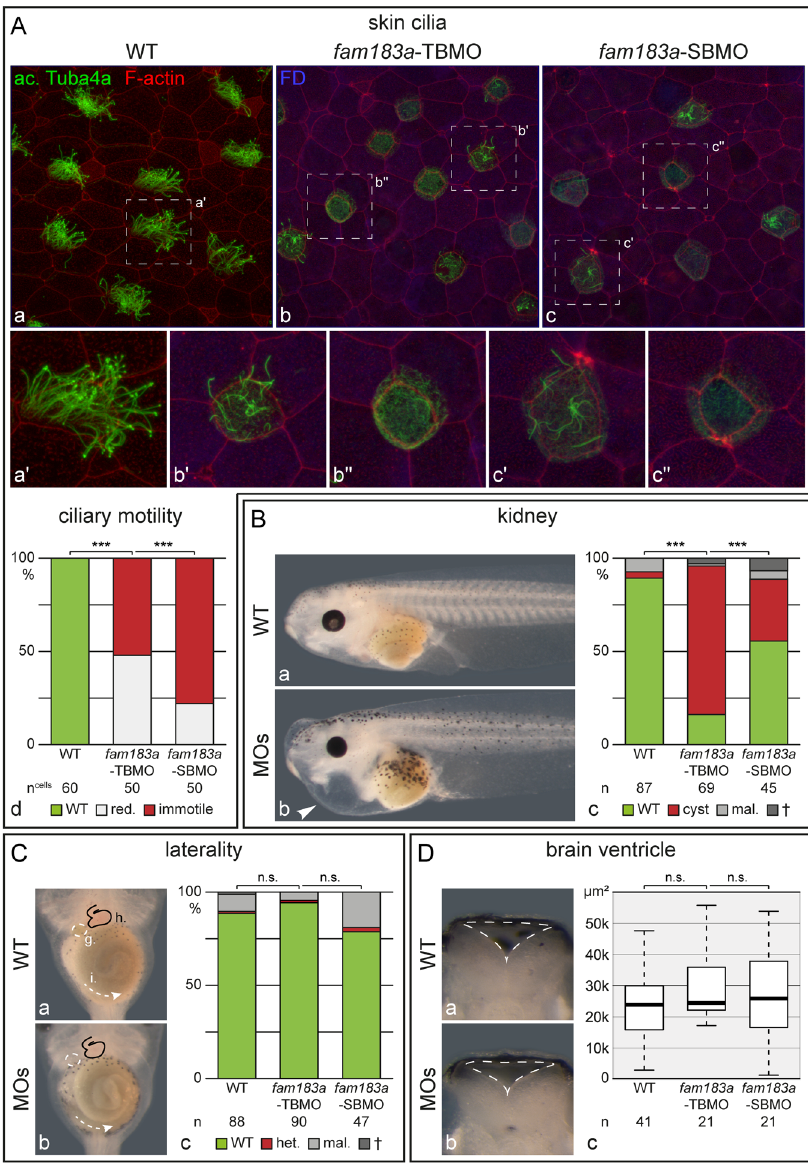
Figure 3. Functional analysis of fam183a in Xenopus laevis . ( A ) Embryos at the 4-cell stage were injected with fam183a -TBMO (b) or -SBMO (c), cultured to stage 33 and analysed for epidermal MCC ciliation (a–c) and ciliary beating (d). Note that cilia were reduced in length and number in MCCs of morphant specimens. Stippled boxes in (a–c) indicate the regions shown enlarged (a’–c”). Edemata ( B ), organ situs ( C ) and hydrocephalus ( D ) were analyzed at stage 45. Note that epidermal cilia defects and cardial edemata, were encountered in a statistically significant proportion of specimens, while rare LR defects and hydrocephalus were not significant. White arrowhead in ( B b) highlights cardial edema; arrangement of inner organs and gut coiling in ( C a,b) was illustrated by outlines and arrows, respectively; ventricular margins in ( D a,b) were depicted by strippled outlines. FD: fluorescin dextran; g: gall bladder; h: heart; het., heterotaxia; i: intestine; mal: malformed; red. reduced; Sa: situs ambiguus; Si: situs inversus; Ss: situs solitus; + :